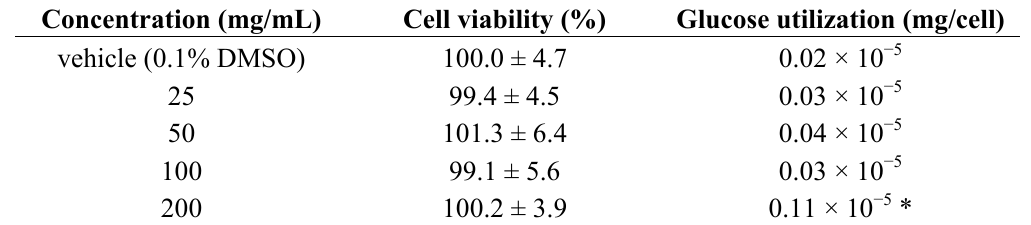
Table 2. Effects of BSK Extract on Cytotoxicity and Glucose utilization in 3T3-L1 Preadipocytes. Concentration (mg/mL) Cell viability